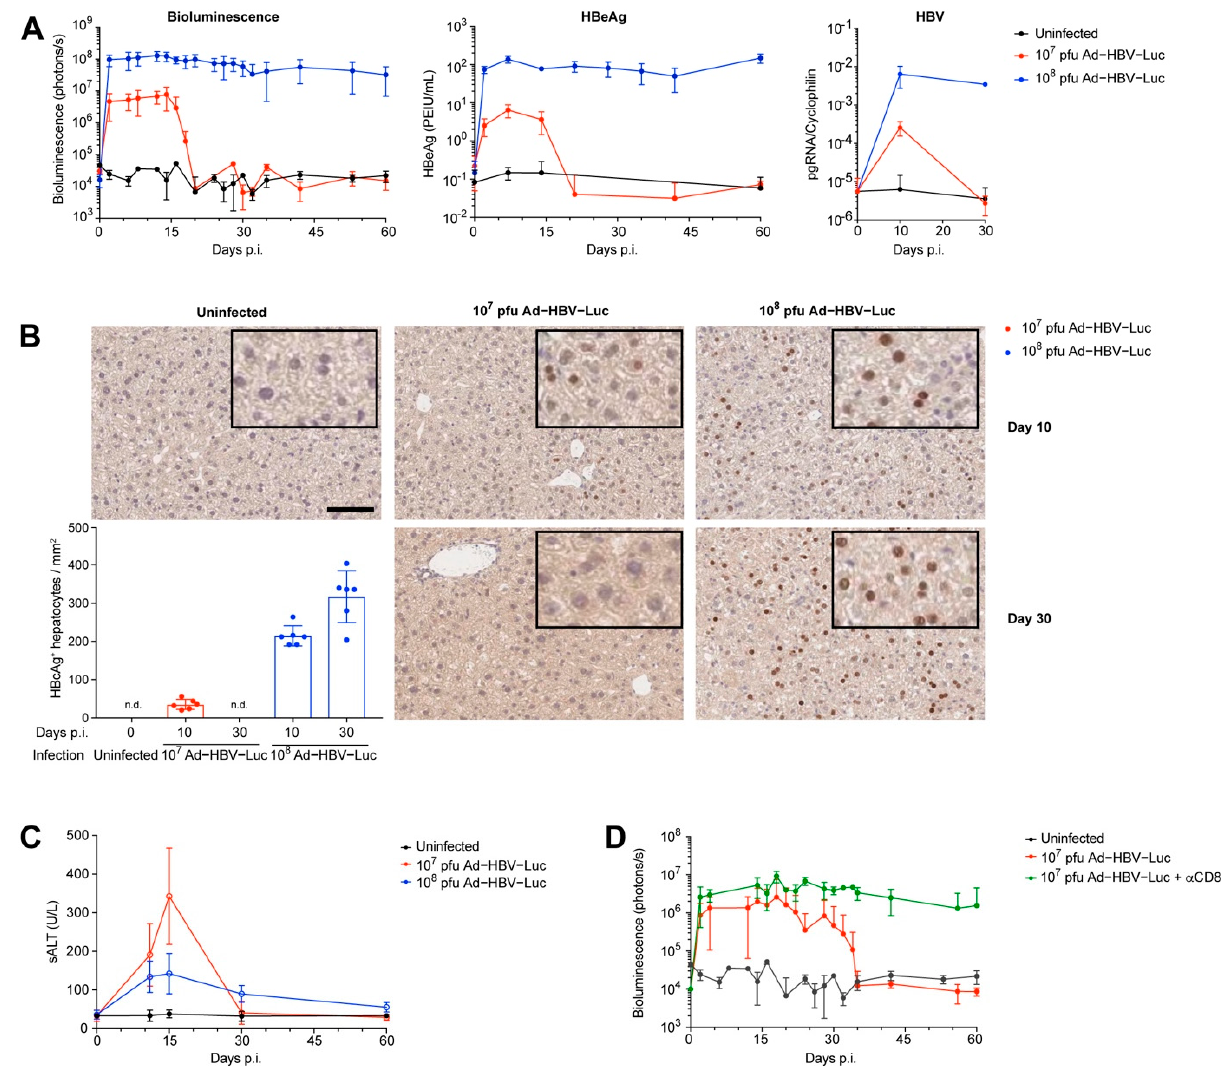
Figure 2. Ad-HBV-Luc infectious dose defines acute self-limited or chronic HBV infection in immunocompetent mice. ( A – C ) C57Bl/6 mice were infected i.v. with the acute self-limited (10 7 pfu, red) or chronic (10 8 pfu, blue) infectious dose of Ad-HBV-Luc. ( A ) Kinetics of the bioluminescence signal in livers, serum HBeAg levels and pgRNA in liver tissue. ( B ) Repre- sentative immunohistochemical HBcAg staining of liver sections and quantification of HBcAg-positive hepatocytes at in- dicated time points after infection. Scale bar = 100 µm. ( C ) Time kinetics of liver damage measured by sALT levels. ( D ) Quantification of virus-infected hepatocytes by bioluminescence signal in the liver of C57Bl/6 mice infected i.v. with the